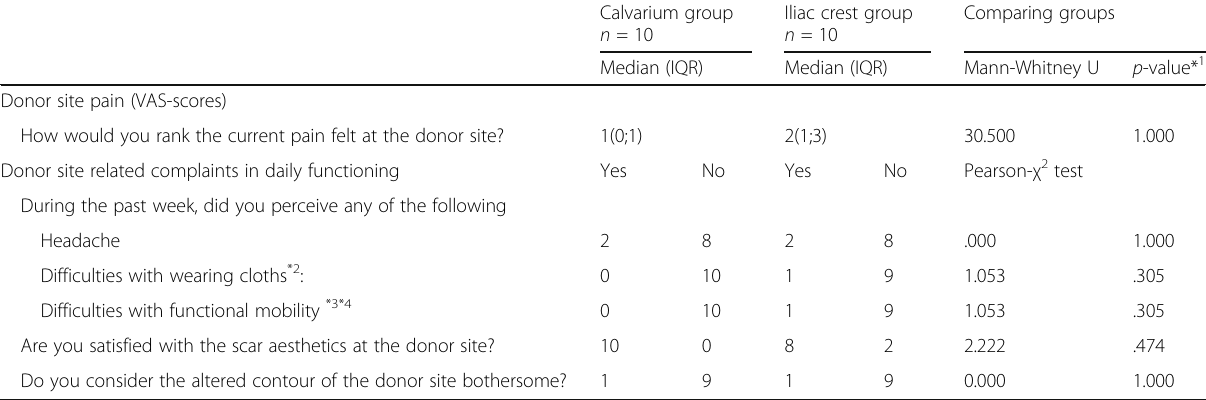
Table 5 Patient reported outcomes of bone graft harvesting surgery per